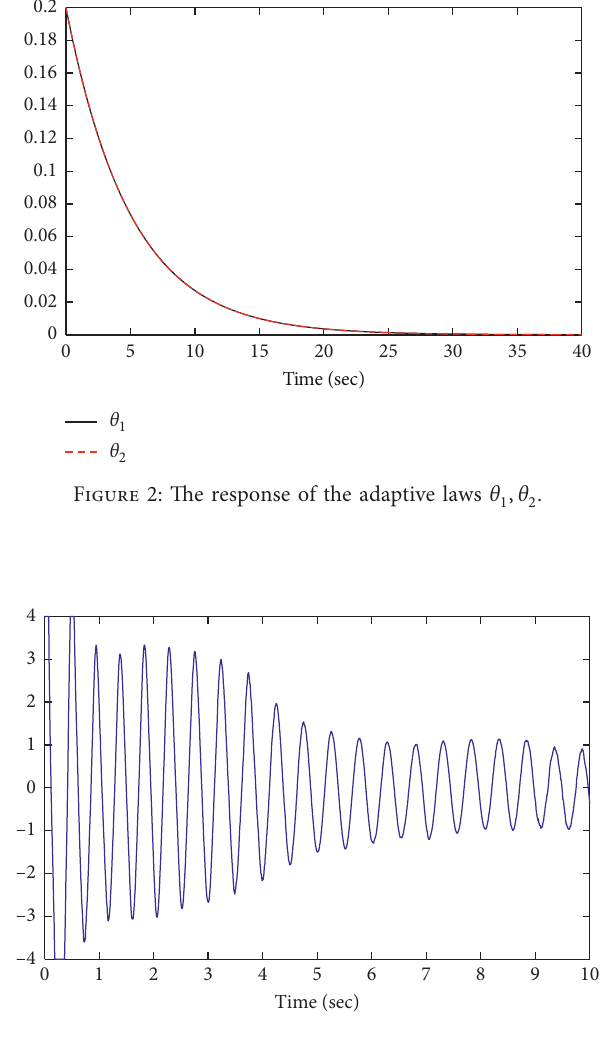
Figure 3: The response of the control input signal u